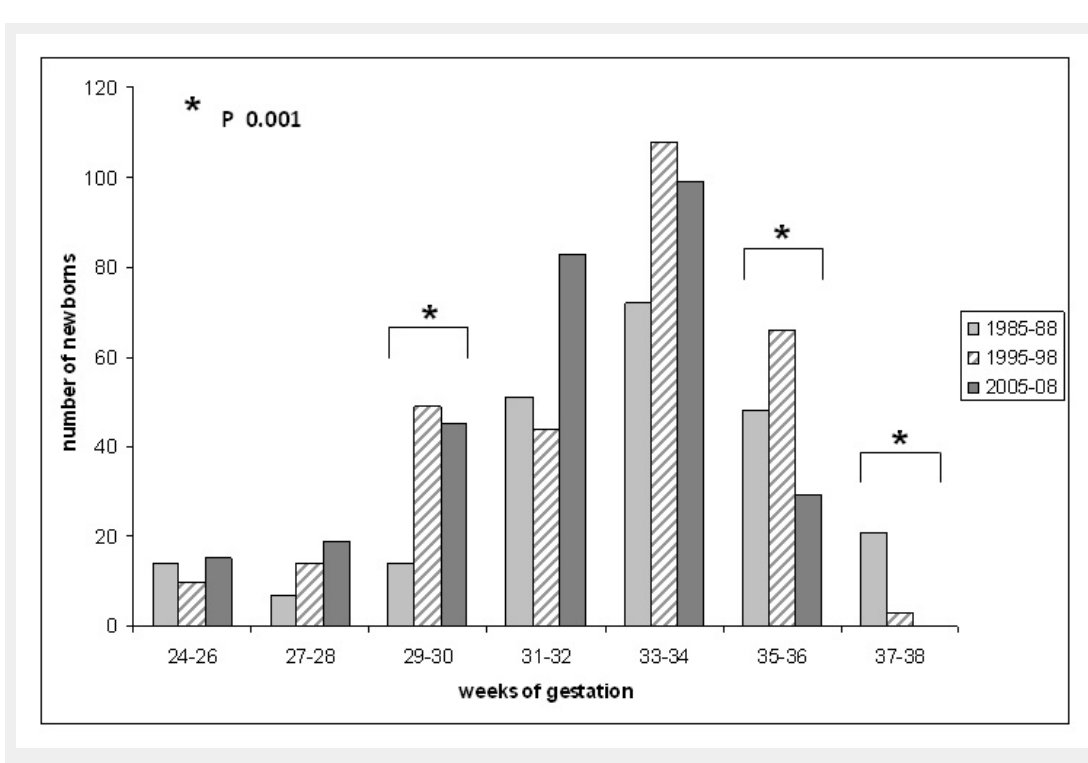
Figure 1 Distribution of live born triplets according to gestational age in the three Swiss